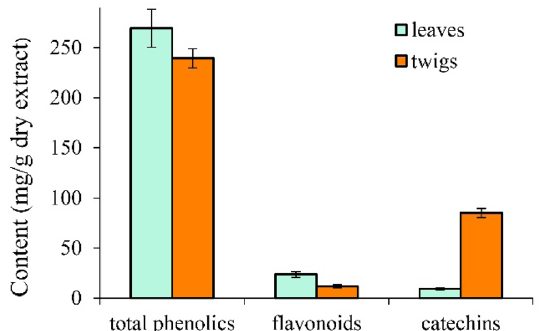
Figure 2. Content of phenolic compounds in the extracts of Hippophae rhamnoides L . leaves and twigs. Values are means ± SD (n = 3).